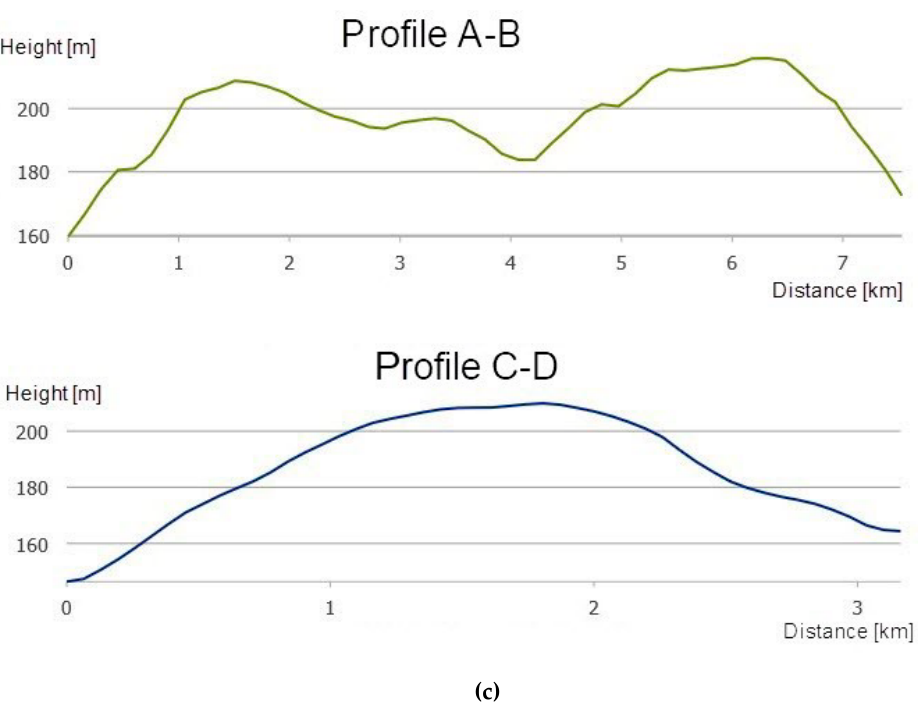
Figure 4. The former sulfur mine of the Machów research area: ( a ) digital terrain model (DTM) , ( b ) hillshade, and ( c ) terrain profiles. AMSL—above mean sea level.